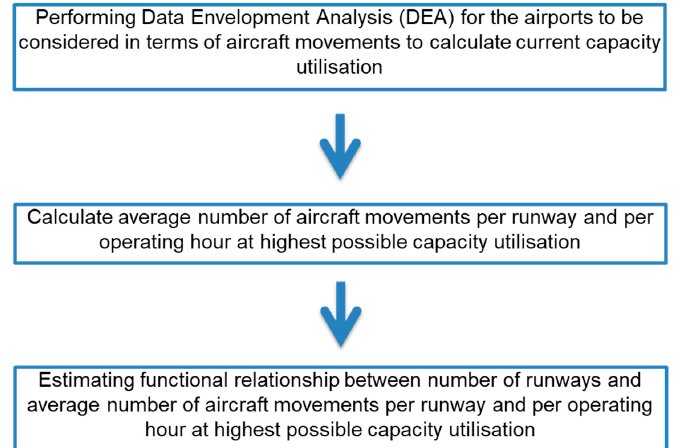
Figure 5. Estimation of the generic airport capacity model.